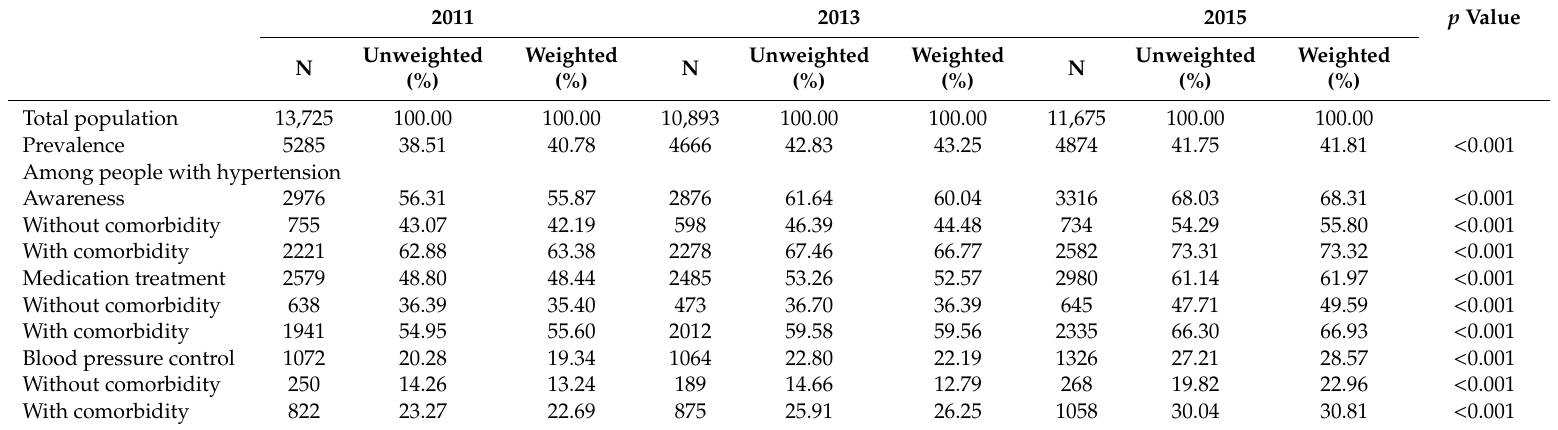
Table 2. Prevalence and healthcare of hypertension among adults 45 years and above in China from 2011 to 2015.